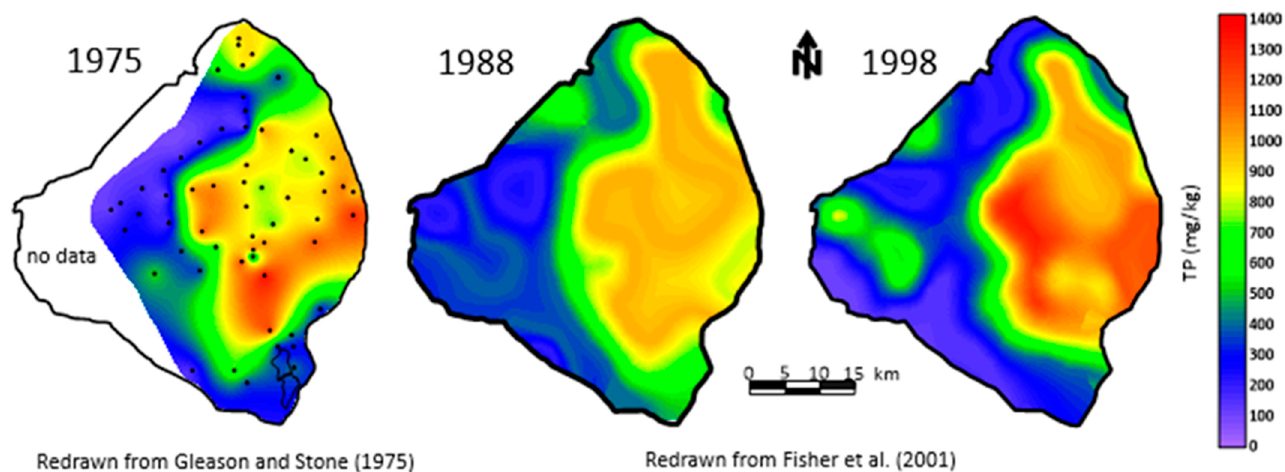
Figure 7. Total phosphorus in the bottom sediments of Lake Okeechobee (in mg/kg) [4,29].